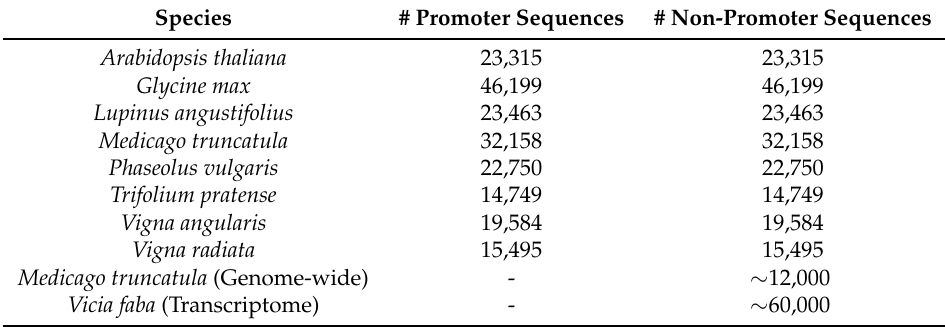
Table 1. Number of promoter and non-promoter sequences in the sets that were used as training sets. Species # Promoter Sequences # Non-Promoter Sequences Arabidopsis thaliana 23,315 23,315 Glycine max 46,199 46,199 Lupinus angustifolius 23,463 23,463